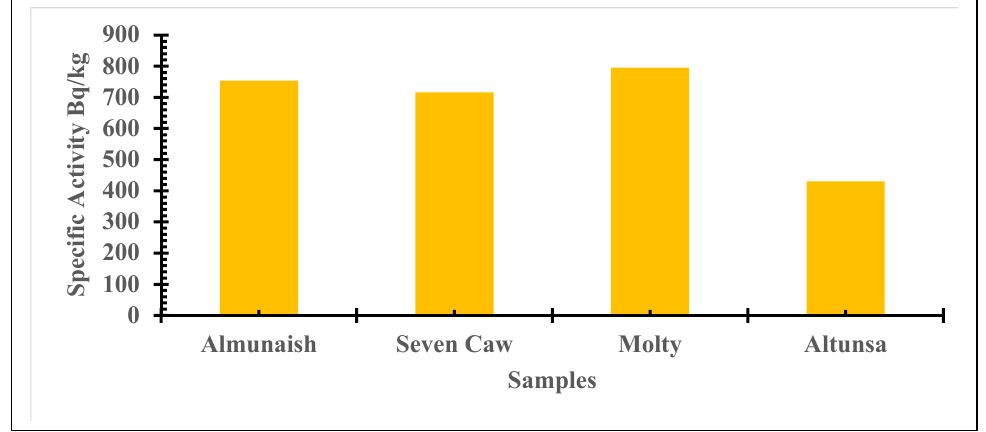
Fig. 3: The specific activity for 40 K in all samples.